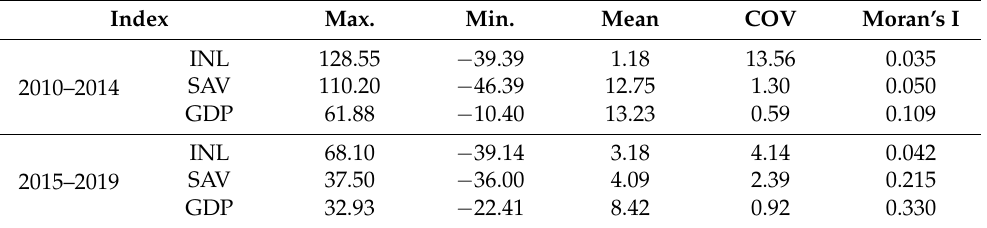
Table 1. Statistical analysis of average annual growth